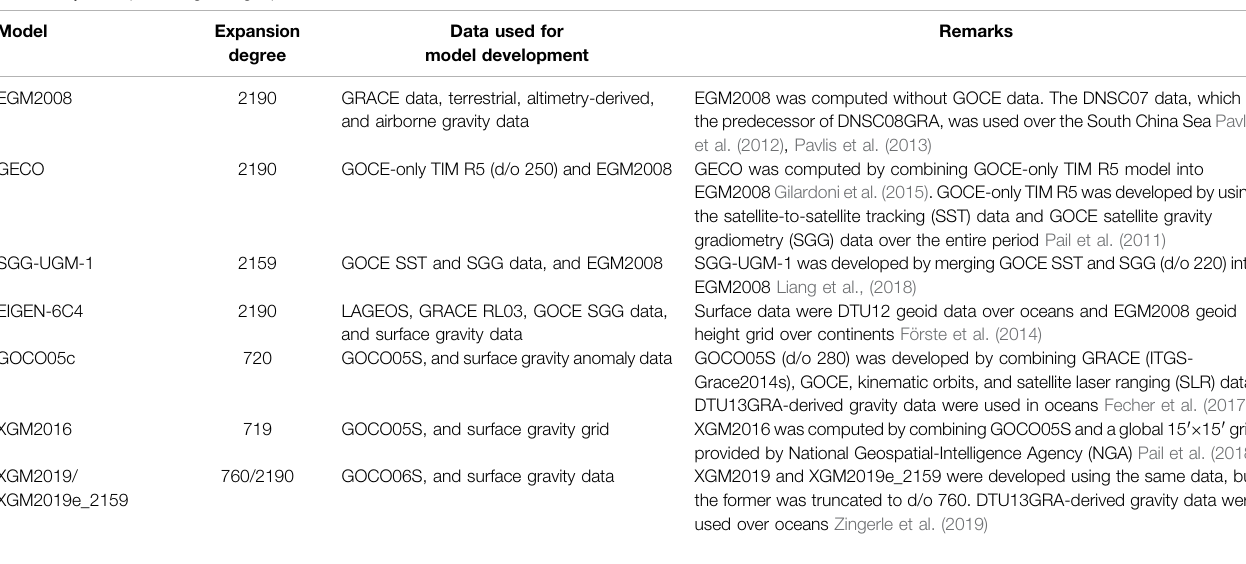
TABLE 1 | Description of global geopotenital